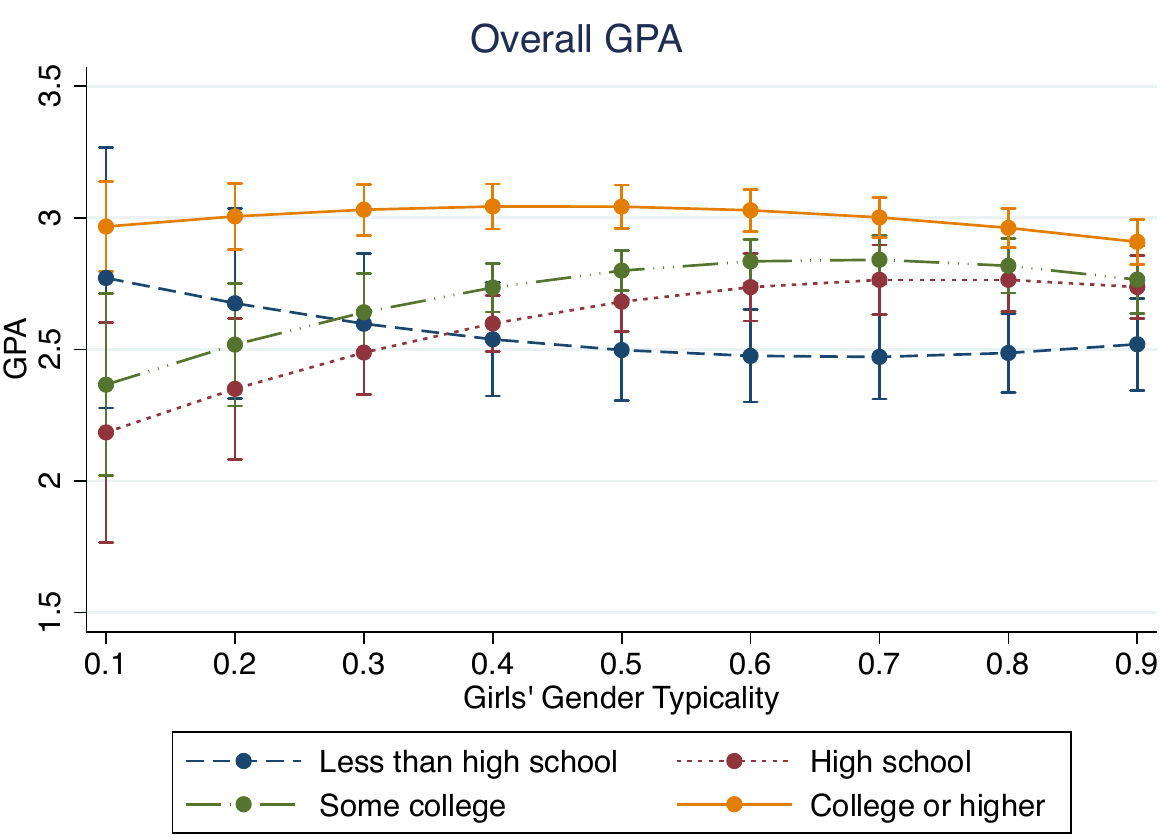
Figure 4: Adjusted predictions of girls’ grade point averages by parents’ education levels and gender